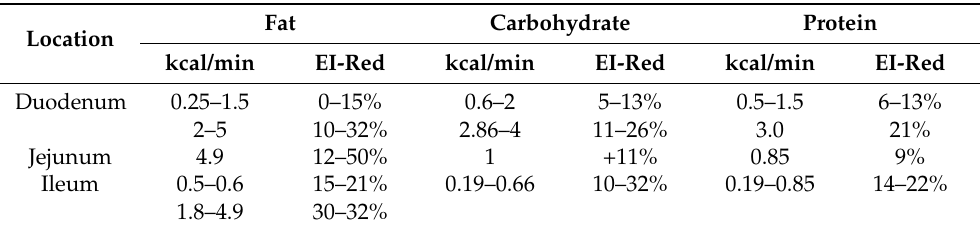
Table 4. Comparison of Energy Intake reduction (EI-red) in response to infusion of equicaloric amounts of fat, protein or carbohydrate (infusion rate in kcal/min) per location: duodenum, jejunum or ileum. Combined results of data obtained from published studies (see references). Fat Carbohydrate Protein Location kcal/min